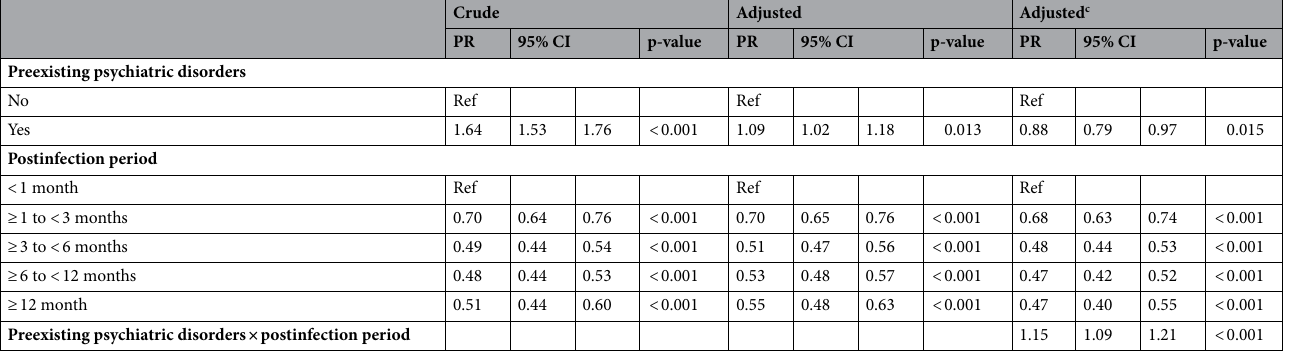
Table 2. The prevalence ratios (PRs) of post COVID-19 symptoms estimated using Poisson regression analysis with robust error variance (n = 6015). a PRs were estimated using Poisson regression analysis with robust error variance. b Adjusted: early dyspnea of COVID-19, more than five early symptoms of COVID-19, treatment of COVID-19, K6, GAD-7, age, gender, education, work status, cohabitation, and medical history. c Interaction: preexisting psychiatric disorders × postinfection period included in the statistical model.